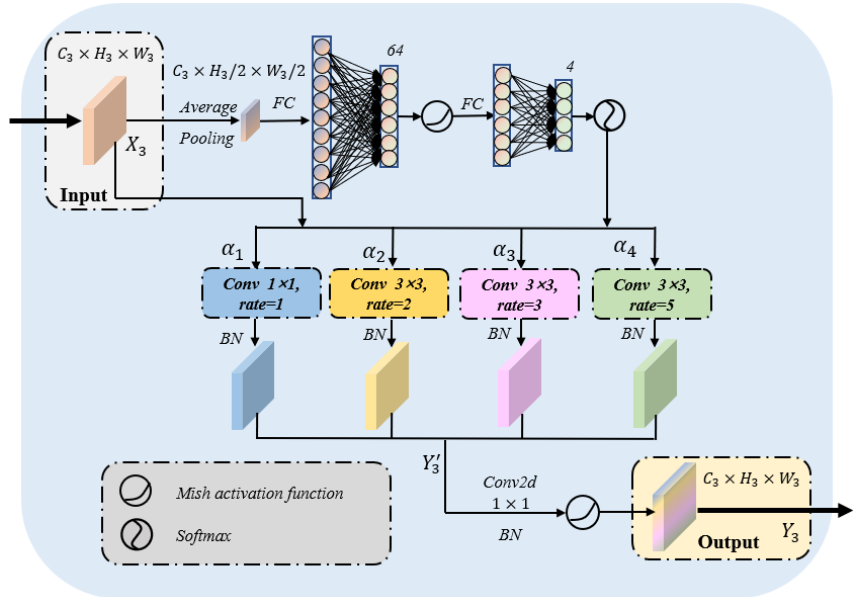
Figure 6. The specific structure of nodule adaptive convolution module. FC denotes the fully connected layer, and α 1 , α 2 , α 3 and α 4 represent the adaptive ratios of each convolution when dealing with different